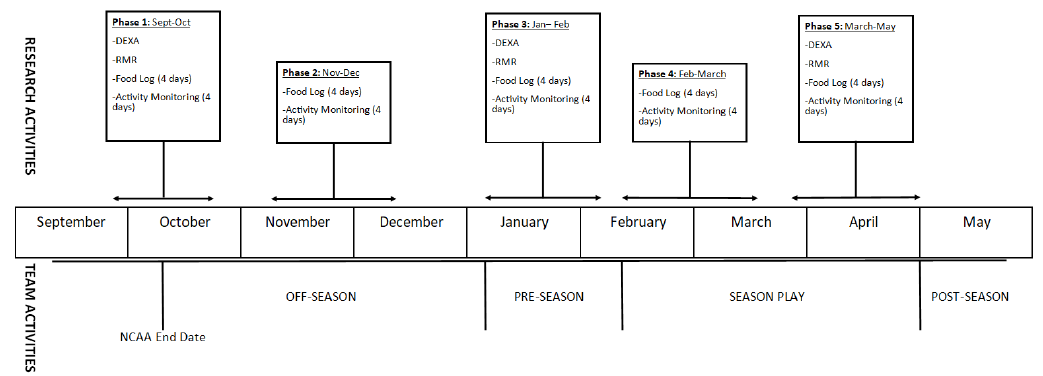
Figure 1. Overview of research and team activities. DEXA, dual energy X-ray absorptiometry; RMR, resting metabolic rate.